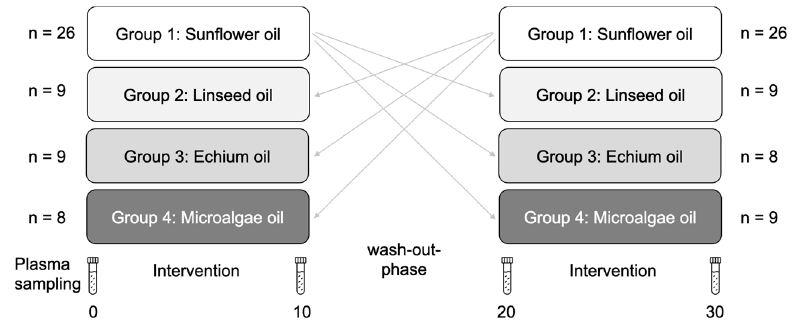
Figure 1. Study design and blood sampling. Participants consumed (per day) approximately (A) 20.0 g sunflower oil with a mean content of 10.0 g LA or (B) 20 g linseed oil containing 7.4 g ALA or (C) 20.0 g echium oil with 4.8 g ALA and 1.6 g SDA or (D) 12.0 g microalgae oil powder with 1.6 g DHA.